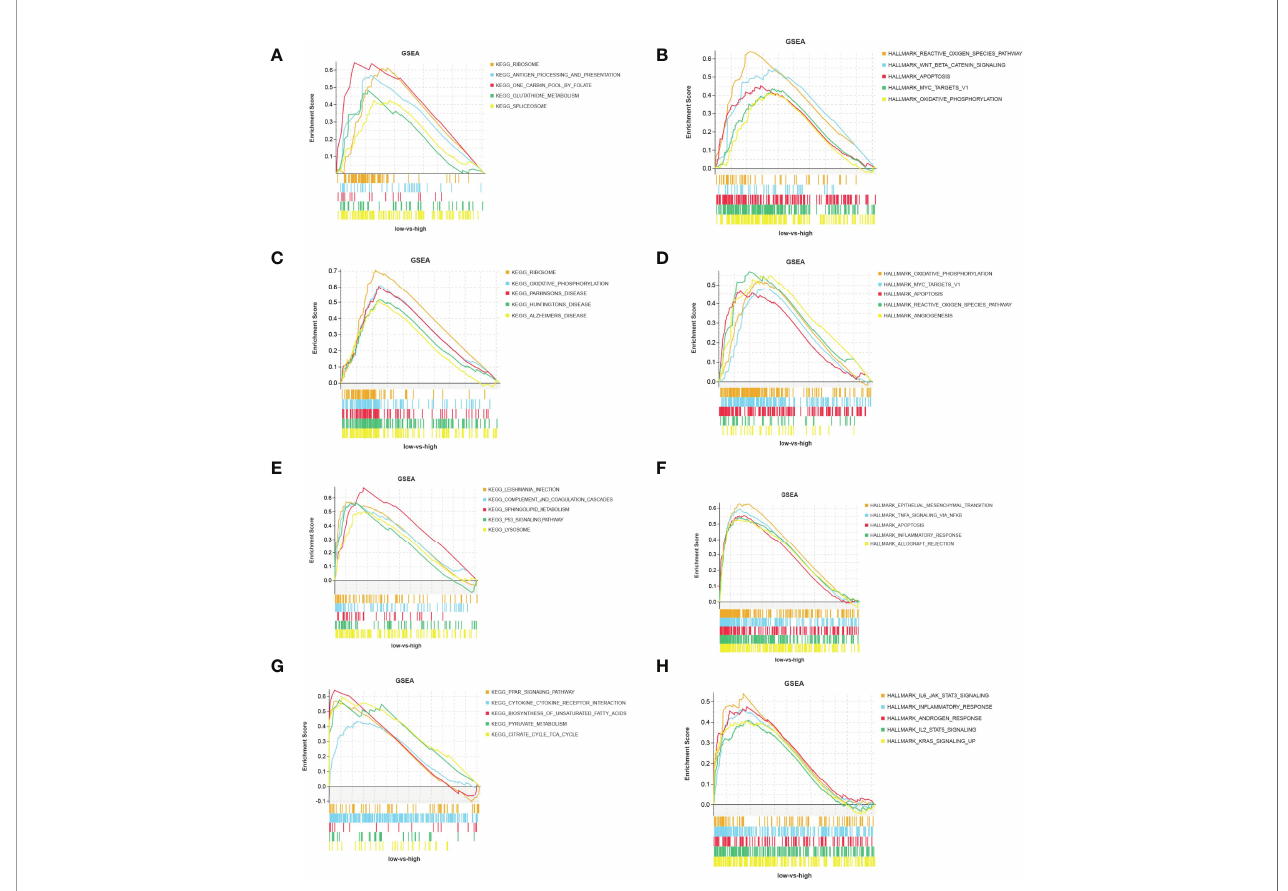
FIGURE 6 | Functional pathways of Timp4 and Cdkn1a. (A, C) KEGG pathway and (B, D) Hallmark pathway of Timp4 and Cdkn1a in the bevacizumab- administered group; (E, G) KEGG pathway and (F, H) Hallmark pathway of Timp4 and Cdkn1a in the combined dataset of GSE6011 and